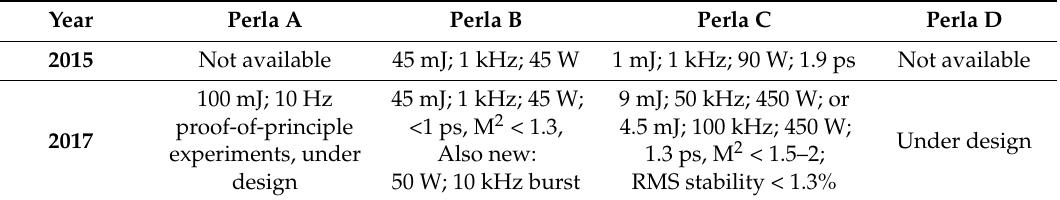
Table 1. Comparison of progress in typical average output power, pulse energy, pulse repetition rate, pulse length (full width at half maximum (FWHM)), and beam quality of Perla thin-disk laser platforms achieved since 2015 [27].